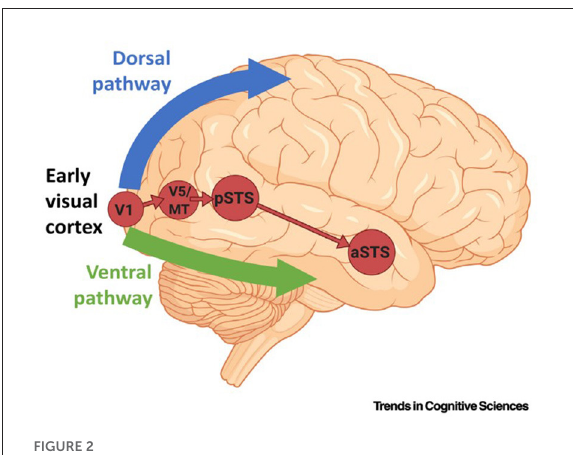
FIGURE2 The pathway begins in the primary visual cortex (V1) and projects into the posterior banks of the superior temporal sulcus (STC) via the motion-selective area V5/middle temporal (MT). The corticocortical connections of the third pathway are independent of the ventral pathway (in green) and the dorsal pathway (in blue). a/pSTS, anterior/posterior